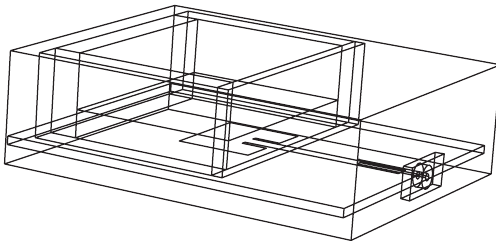
Figure 1: Numerical model of sensor geometry in COMSOL Mul- tiphysics.